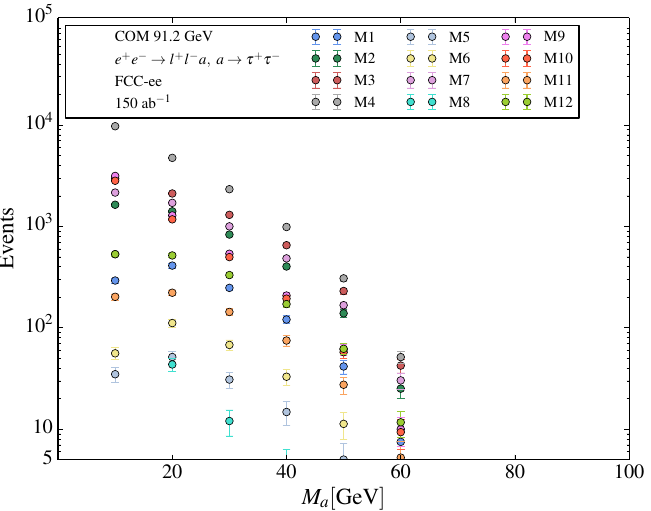
Figure 8. Rates at a 91 GeV FCC-ee for various models discussed in [36], for (cid:96) + (cid:96) − τ + τ − final states. M7 and M10 reach a 3 σ significance using ML techniques. Figure taken from